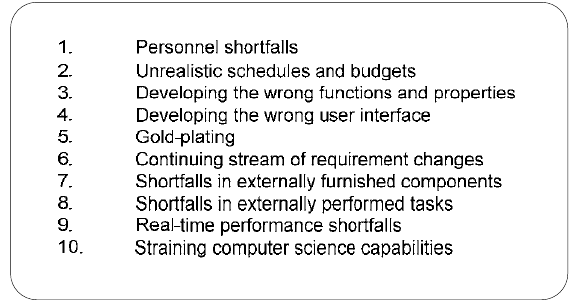
Figure 1: Boehm's 'top ten' list of software risk items.